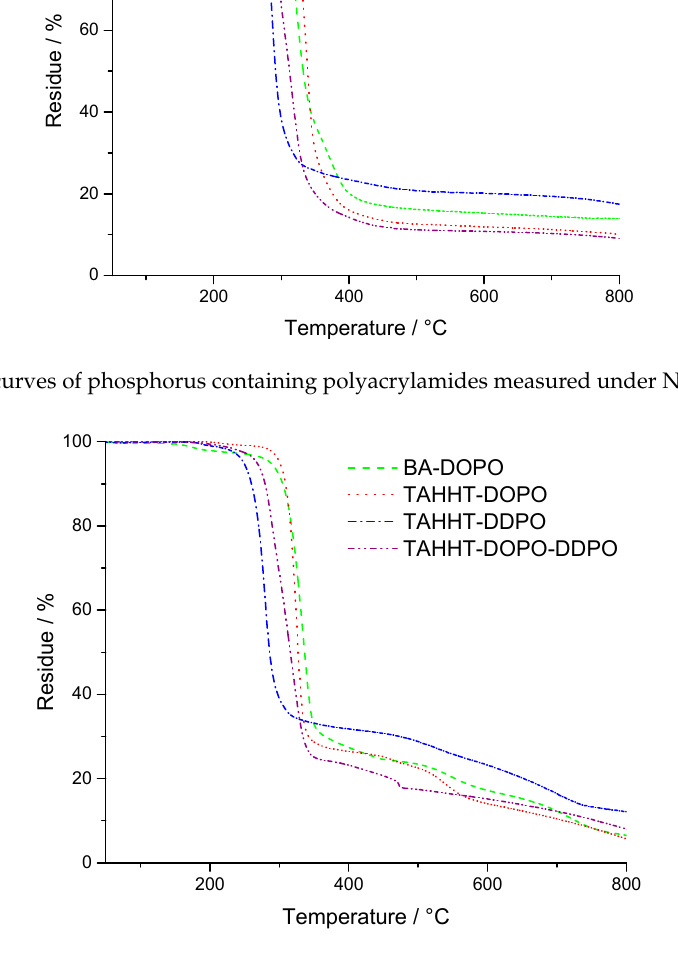
Figure 3. TG-curves of phosphorus containing polyacrylamides measured in air.